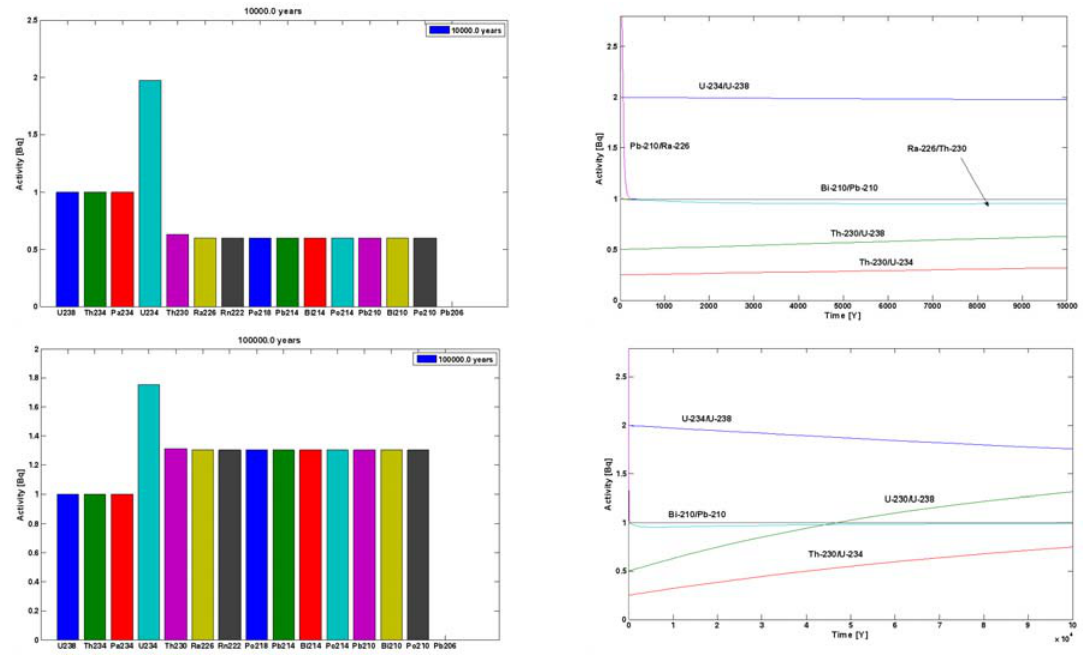
234 U/ 238 U and 230 Th/ 234 U activity ratio methods are applied. Evolution of short-lived nuclide activity ratios is also